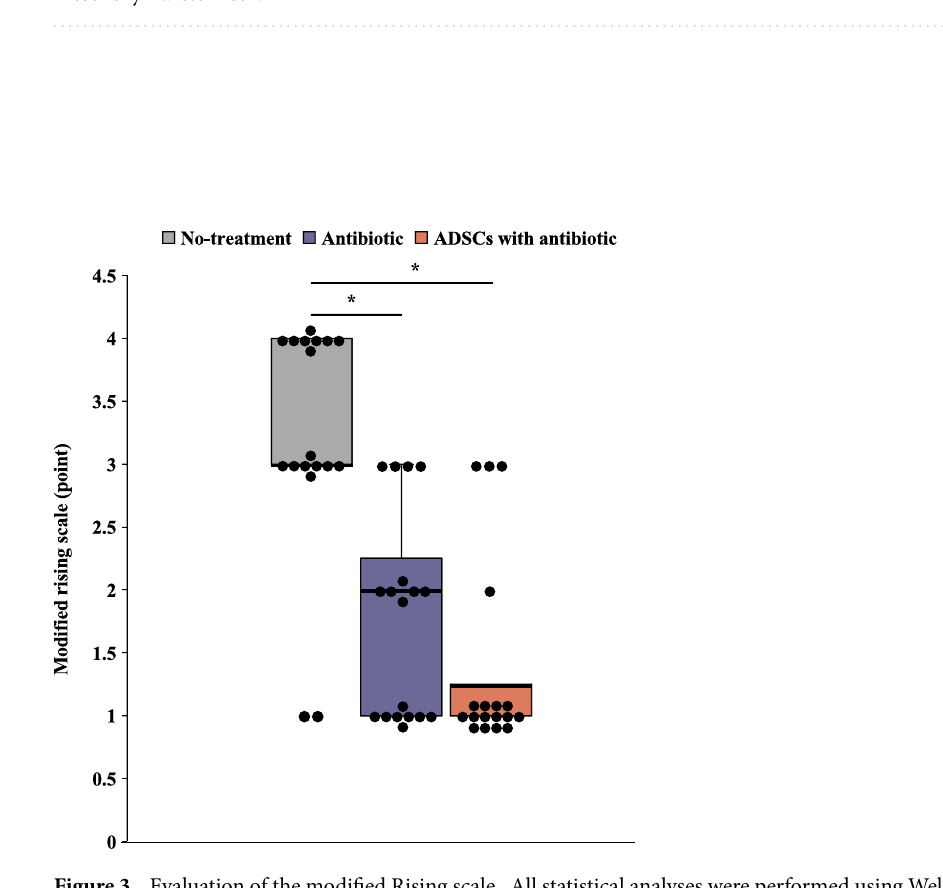
Figure 3. Evaluation of the modified Rising scale. All statistical analyses were performed using Welch ANOVA followed by Tukey HSD post-test (n = 6 rats per group). Data are reported as the median ± interquartile range. *p < 0.05. ADSC adipose-derived mesenchymal stem